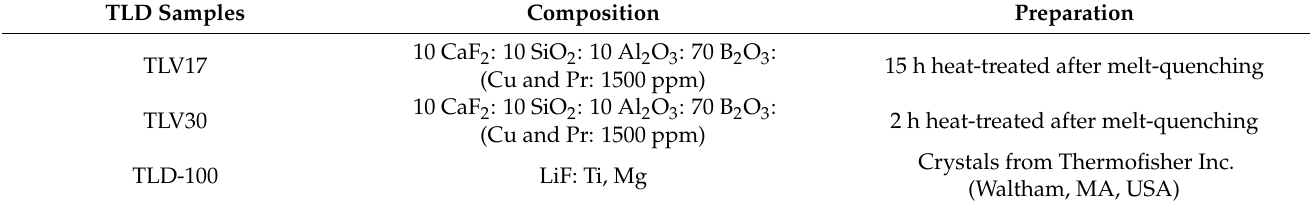
Table 1. Samples, compositions and preparation methods of the TL dosimeters used in the present study. TLD Samples